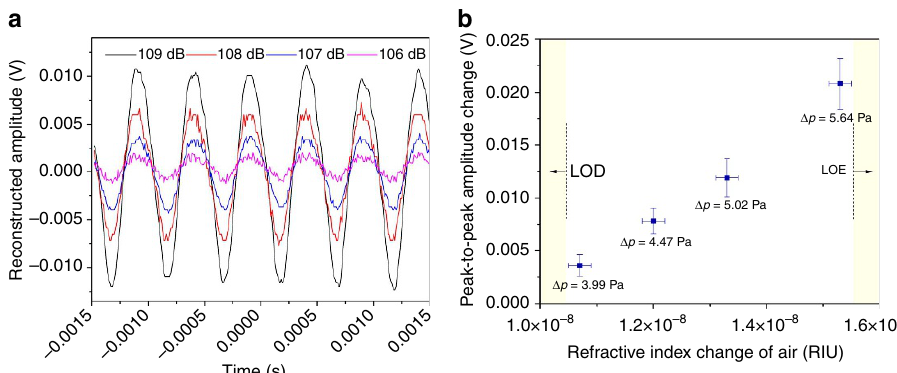
Figure 8 | Determination of the limit of detection (LOD) of the sensor. ( a ) The time response of the photodetector for four different sound levels (colour- coded in dB) with the probe laser tuned to 1,316.270nm, on the edge of the SPP resonance centred at 1,316.382nm. ( b ) The peak-to-peak photodetector voltage change as a function of the surrounding refractive index modulation amplitude (calculated from the air pressure modulation of each sound level). Vertical error bars show the s.d.’s from five independent measurements. Horizontal error bars represent the error made on the computation of the refractive index value due to the uncertainty on the sound measurement (0.1dB). The term LOE means limit of excitation (that is, the maximum sound level available with our system).